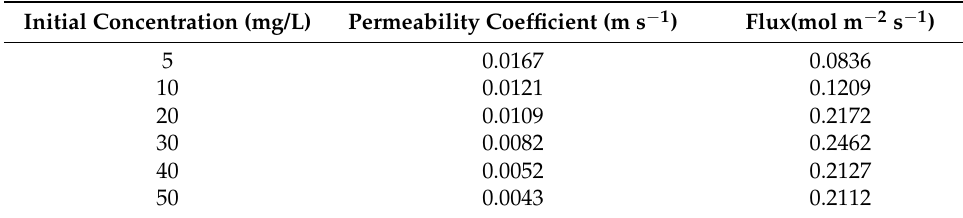
Table 9. The permeability and flux values of Zn 2+ removal by the W3 membrane at different initial